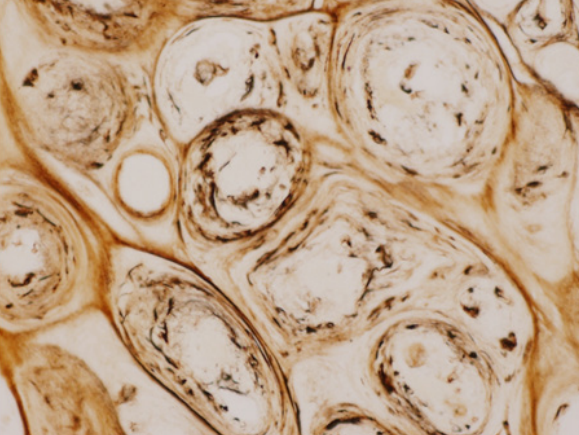
Fig. 9. Target-like chondrocytes in bone trabeculae of the stalk of osteochondroma.HE,